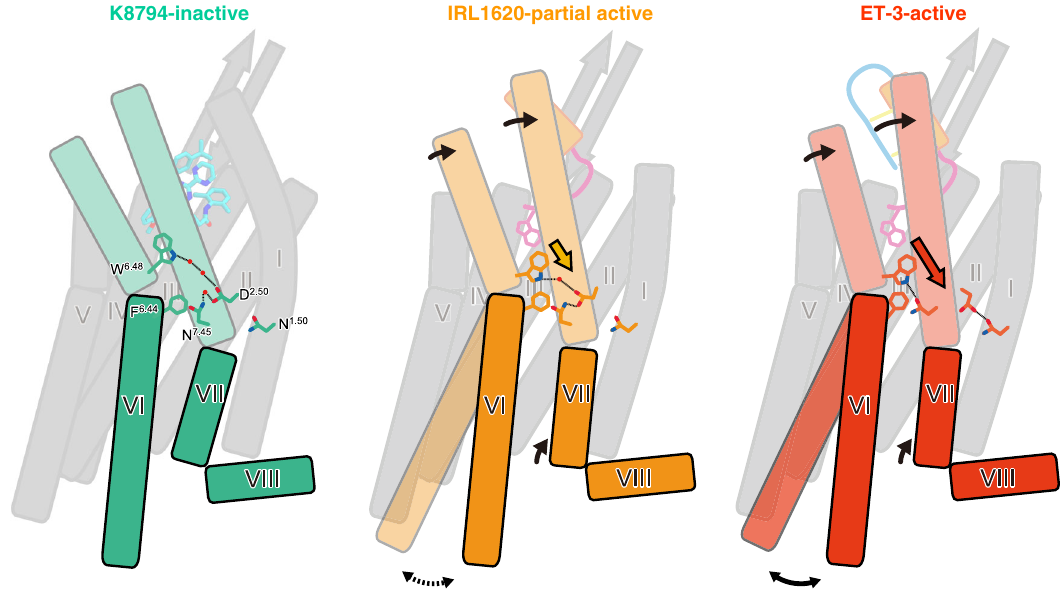
Fig. 6 Receptor activation by ET-3 and partial activation by IRL1620. Schematic representations of receptor activation by ET-3 and partial activation by IRL1620. TM6, TM7, and H8 are highlighted. The residues involved in the signal transduction (N1.50, D2.50, F6.44, W6.48, and N7.45) are represented with sticks. Hydrogen bonds are indicated by black dashed lines. Arrows indicate the conformational changes in TM6 and TM7 upon ET-3 and IRL1620 binding. In the K-8794-bound structure (left), a water-mediated hydrogen bonding network among D147 2.50 , W336 6.48 , and N378 7.45 stabilizes the inactive conformation of the receptor. ET-3 binding disrupts this network and propagates the structural change of the transmission switch comprising F332 6.44 and W336 6.48 (middle), leading to the outward movement of TM6 upon G-protein coupling. In the IRL1620-bound structure (right), the water- mediated hydrogen-binding network is preserved, thus preventing the outward movement of TM6 upon G-protein